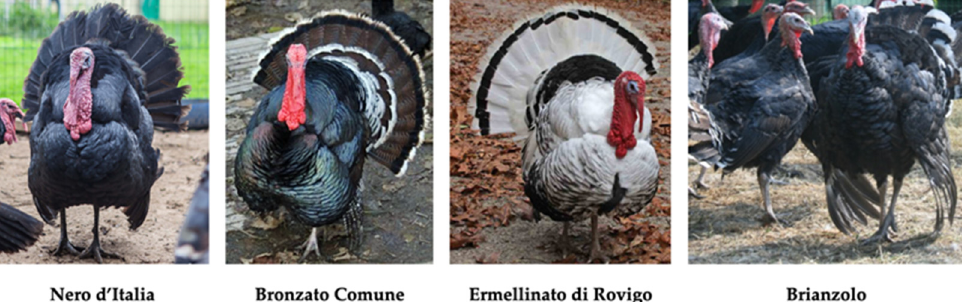
Figure 3. Main native Italian turkey breeds. Reproduced with permission from prof. Silvia Cerolini, TuBAvI Project-coordinator; published at www.pollitaliani.it/en/ (accessed on 6 February 2021) [66].